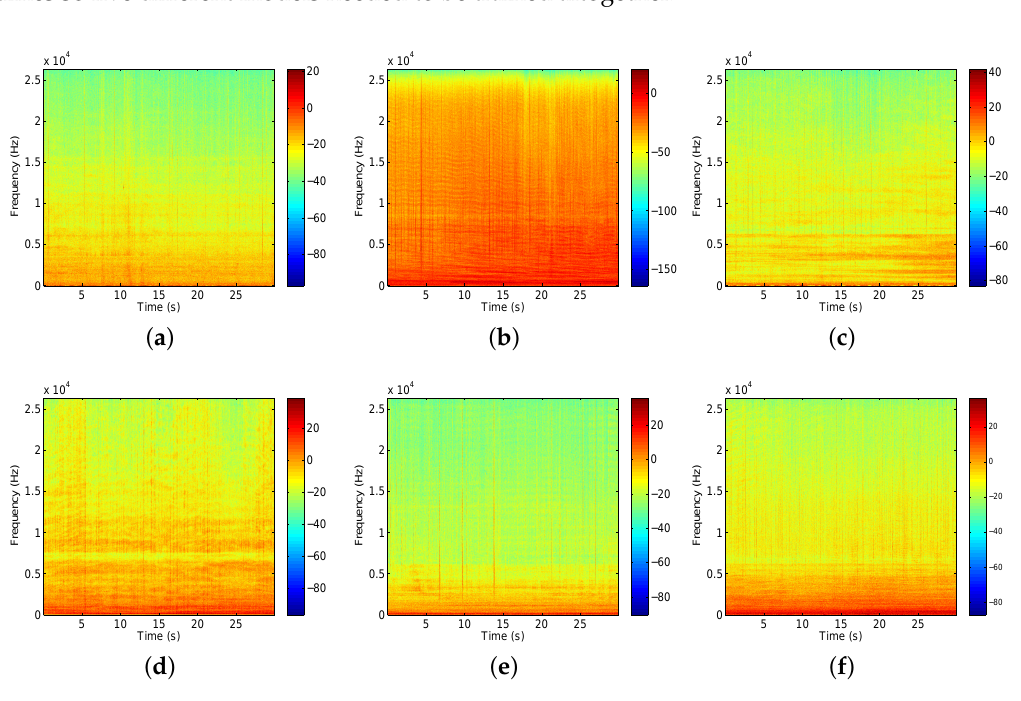
Figure 4. Spectrogram of hydrophone signal for parts of ships. ( a ) background noise; ( b ) motorboats; ( c ) passenger ferries; ( d ) dredger; ( e ) mussel boats; ( f ) ro-ro vessels; Table 2. Database composition of part types of ships in